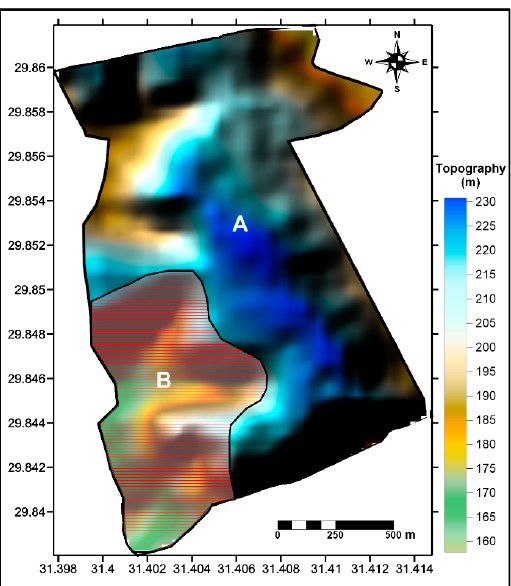
Figure 15. Suggested land-use map of the investigated site: A unit, that represent the optimum area for construction purposes, and B unit, that equivalent to open, parking, garden areas.